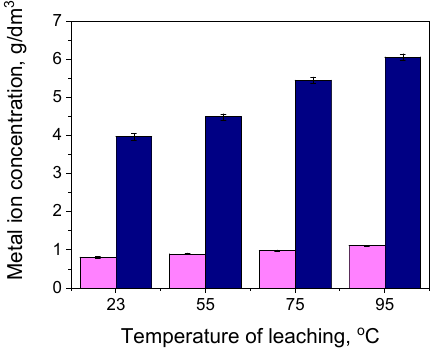
Figure 3. Dependence of Co(II) ( ) and Mo(VI) ( ) concentration in the leach solutions on temperature of leaching for 3 h with 0.5 M H 2 SO 4 at S/L = 1/20 g/cm 3 .